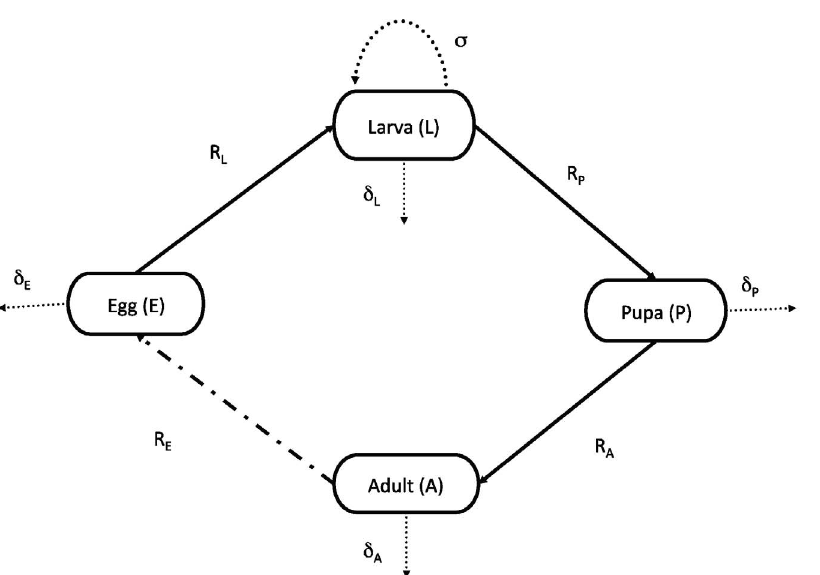
Figure 1. Diagram of the model setup. Each stage experiences temperature-dependent, stage-specific mortality, d i ( i ~ E , L , P or A ). Recruitment into a stage i at time t is given by R i and is also dependent on temperature. Density-dependent mortality is only experienced in the larval stage, s .